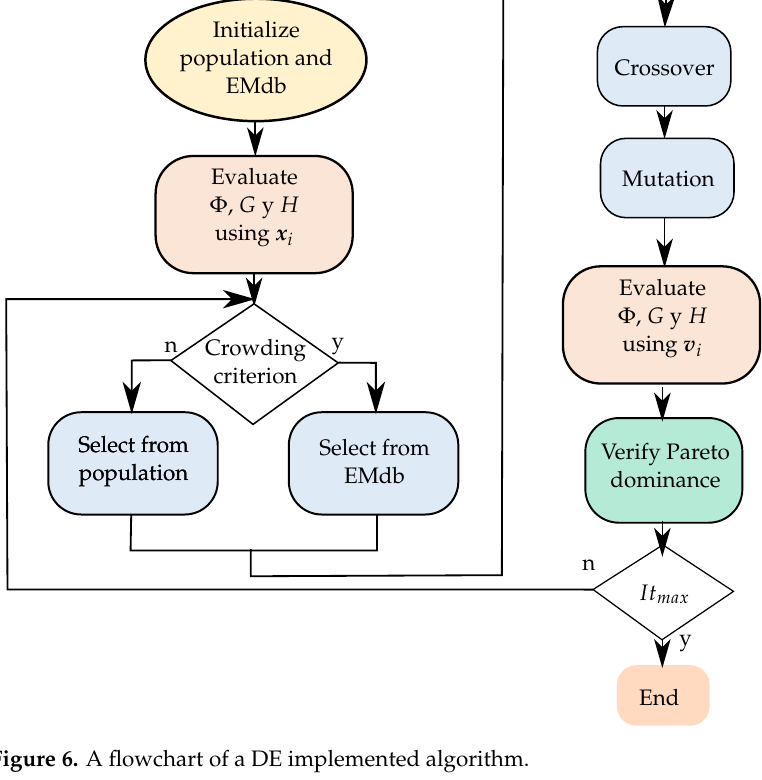
Figure 6. A flowchart of a DE implemented